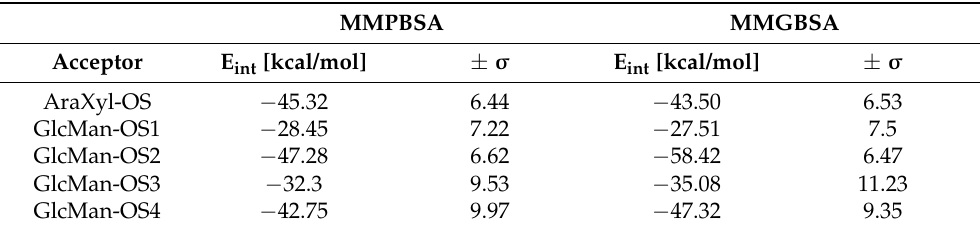
Table 9. Binding free energy values of TmXET6.3 in complex with AraXyl-OS and GlcMan-OS acceptors based on MM(PB/GB)SA calculations. Values were obtained from 800–1000 ns time intervals of MD